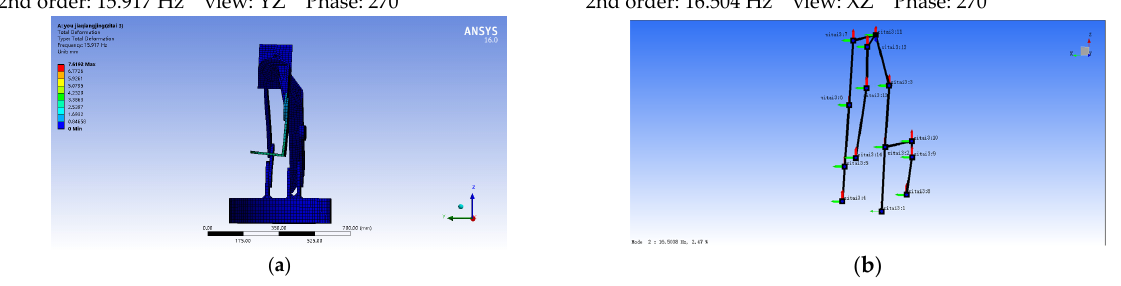
Figure 4. ( a ) Second-order simulation mode diagram; ( b ) Second-order test mode diagram.